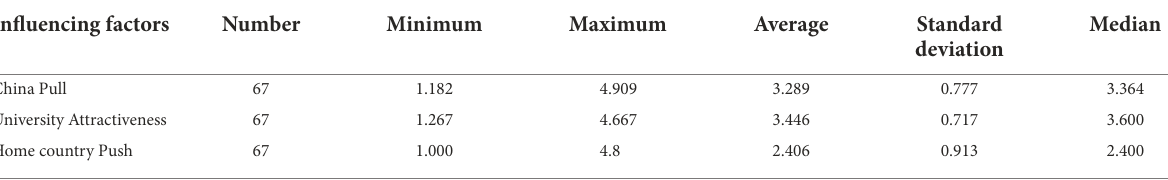
TABLE 2 The overall situation of the influencing factors of international students coming to China.